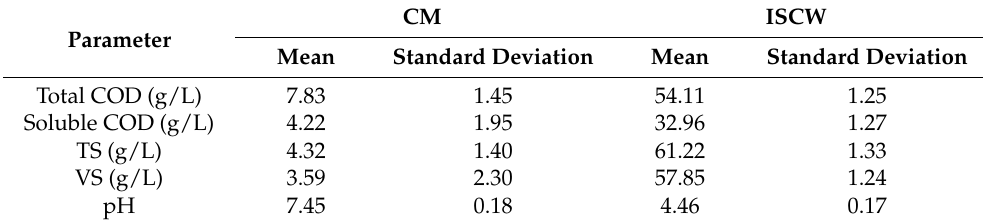
Table 1. Characterization of cattle manure and industrial solid citrus waste.